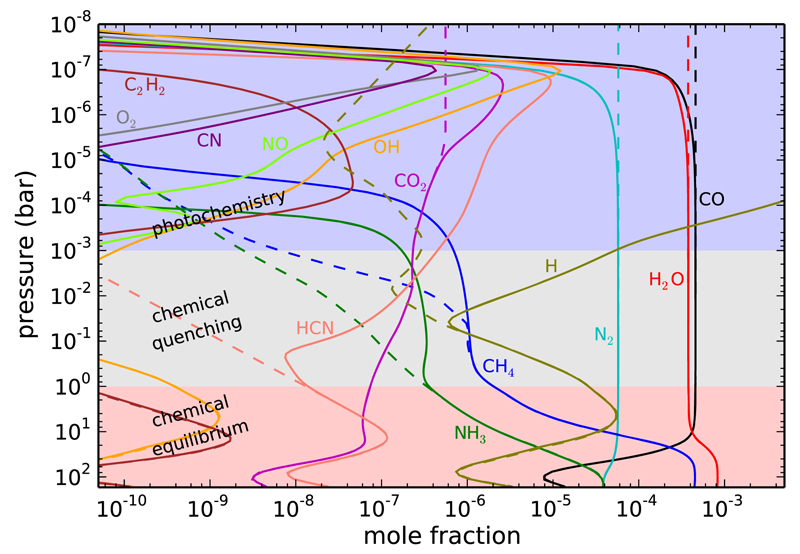
Vertical distribution of abundances at the substellar point of HD 189733b. Dashed lines correspond to chemical equilibrium and solid lines to a one-dimensional vertical model including thermochemical kinetics and photochemistry (Agúndez et al. 2014a). The atmosphere can be schematically divided into three regions where the composition is controlled by either chemical equilibrium, chemical quenching, or photochemistry